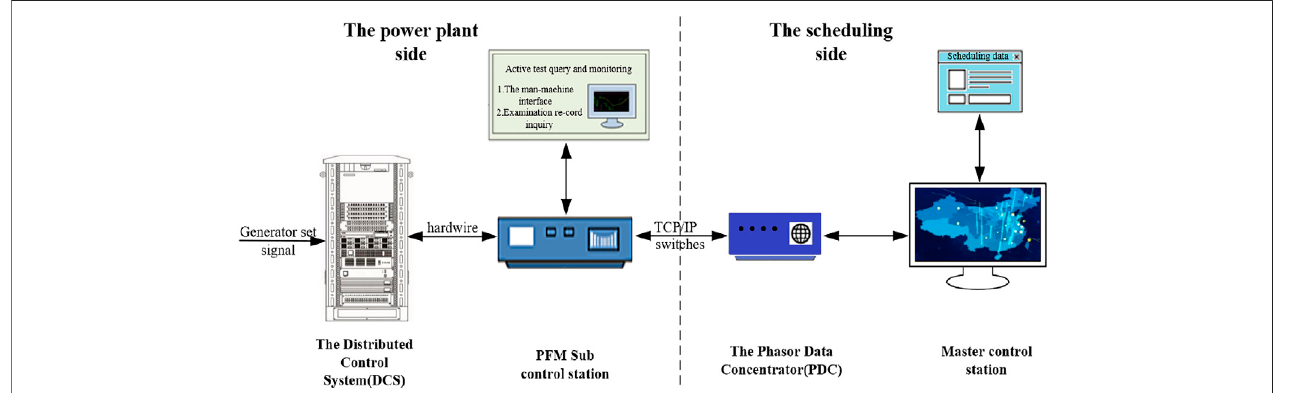
FIGURE 3 | Topological diagram of the control strategy of the PFM monitoring and management system based on the “ master – sub ” control station.